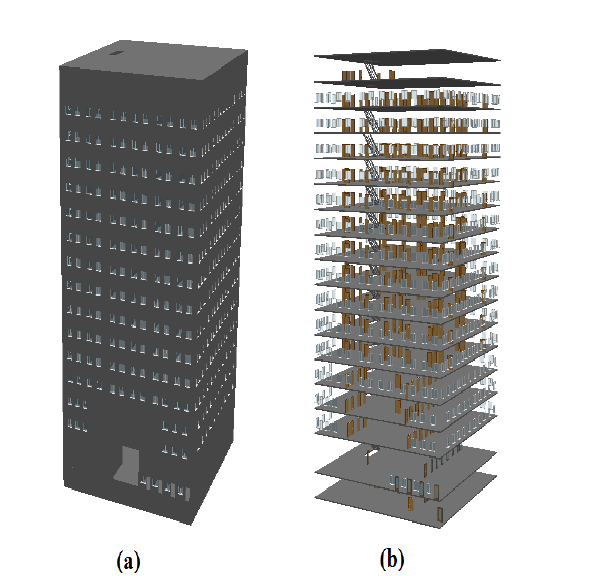
Figure 7. 3D model of Plasco building in the GIS environment (a) Layers of walls and structure (b) Layers of doors, windows and stairs